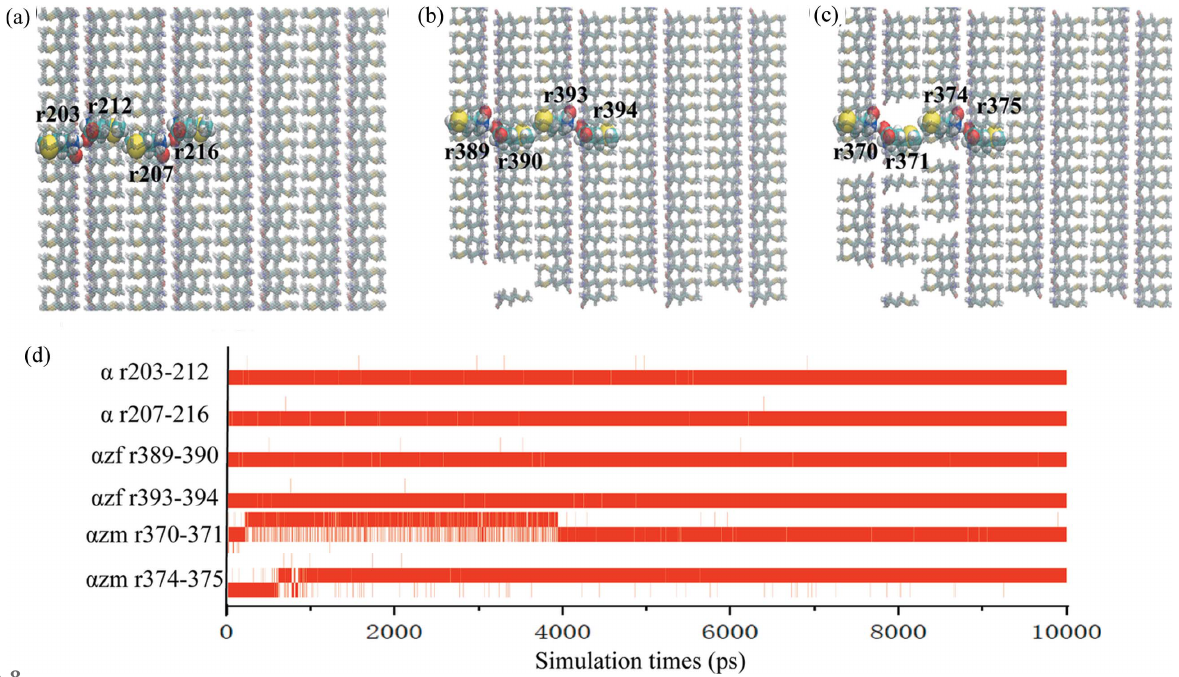
Figure 8 Snapshots of the initial structure of the (cid:2) polymorph with ( a ) no vacancy defects, ( b ) low vacancy-defect density and ( c ) high vacancy-defect density. ( d ) Hydrogen bond lifetime under different conditions. The hydrogen bonds between molecules 203 and 212, 207 and 216 were investigated under the no defect condition; 389 and 390, 393 and 394 for low defect density; and 370 and 371, 374 and 375 for high defect density.